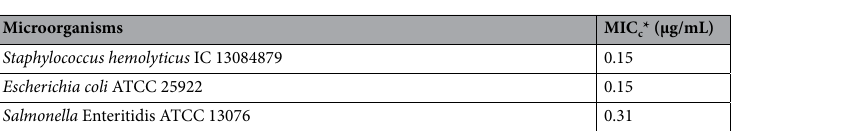
Figure 5. Antifungal activity of the compounds against Penicillium janthinellum at three different concentrations determined using the poisoned food method. ( A ) 10% concentration, ( B ) 7% concentration, and ( C ) 5% concentration. Control: the growth of filamentous fungi in a medium without drugs. Values are means (n = 3) ± standard deviations.